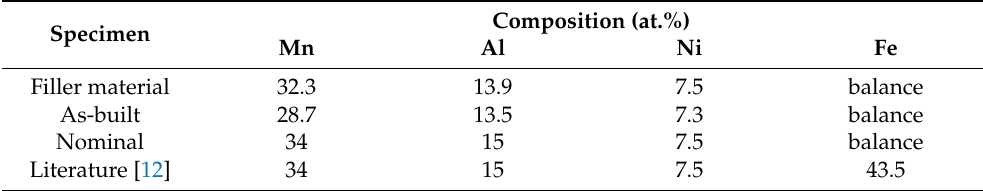
Table 1. Mean chemical composition of the filler material and the as-built state measured using ICP-OES. Composition (at.%) Specimen Mn Al Ni Fe Filler